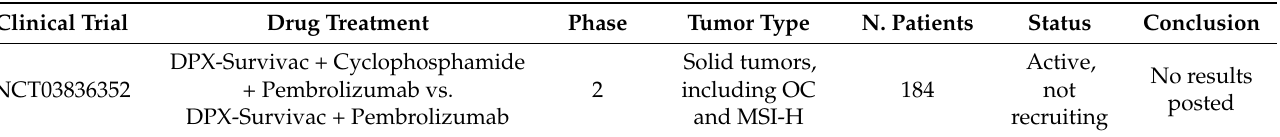
Table 6. Clinical trials for immune checkpoint inhibitors treatment of MSI